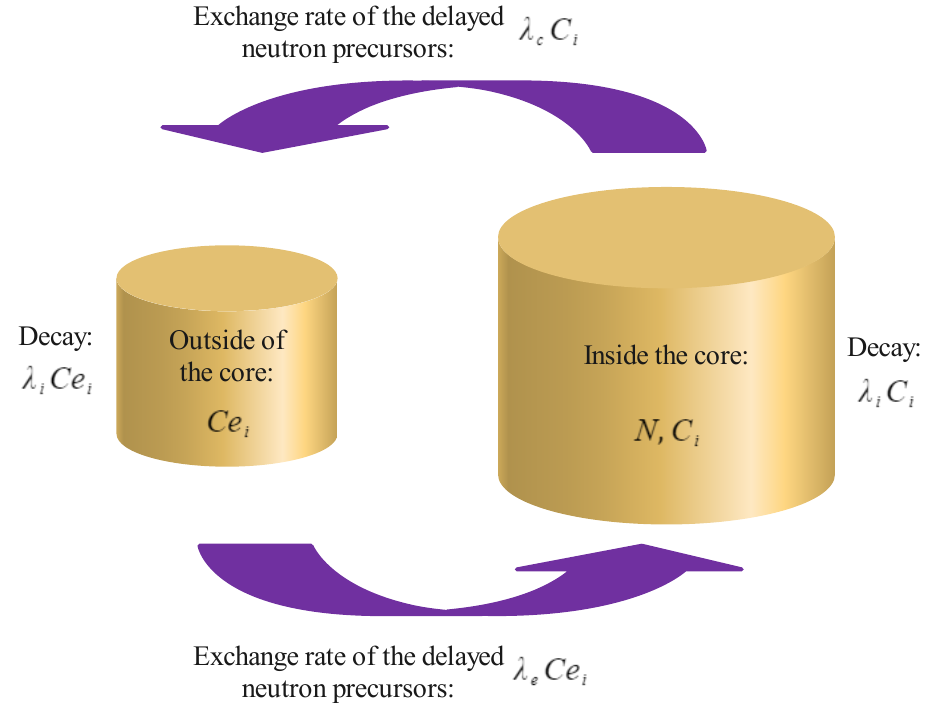
Figure 4. Schematic of the balance of delayed neutron